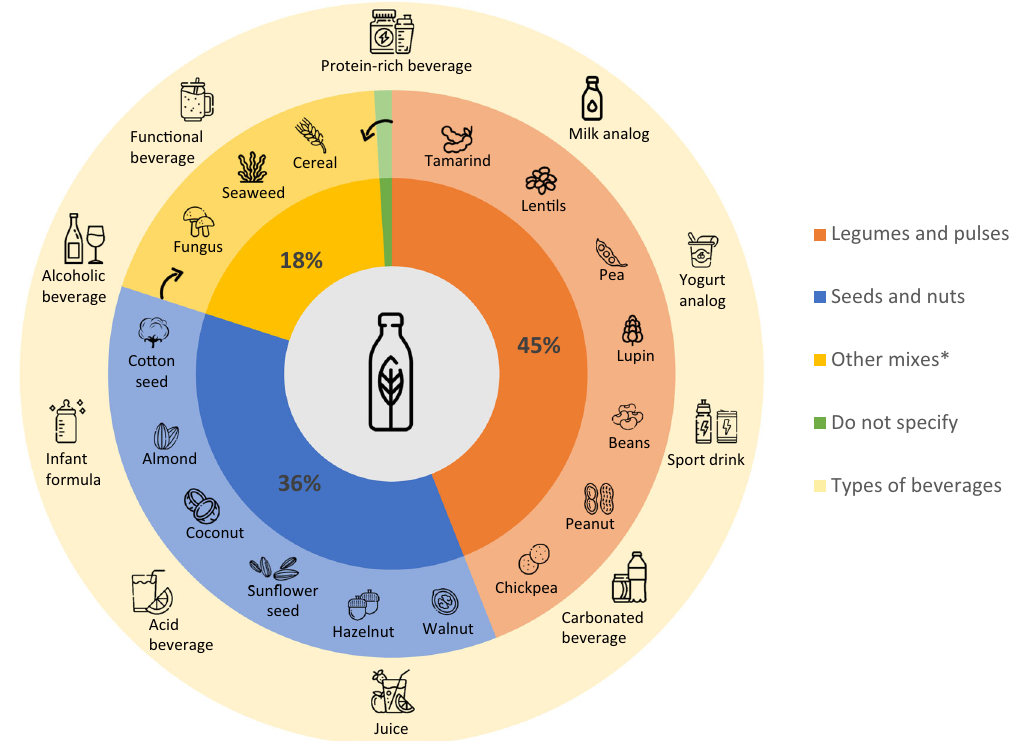
Fig. 4 Distribution of raw material groups and beverage types that can be produced. Legumes and pulses examples are highlighted in orange; seeds and nuts, in blue; other mixes, in yellow; do not specify, in green; beverage types are expressed in light yellow. *Other mixes include patents that used “ legumes and pulses ” and/or “ seeds and nuts ” and/or other components, such as cereal, seaweed, and fungus.